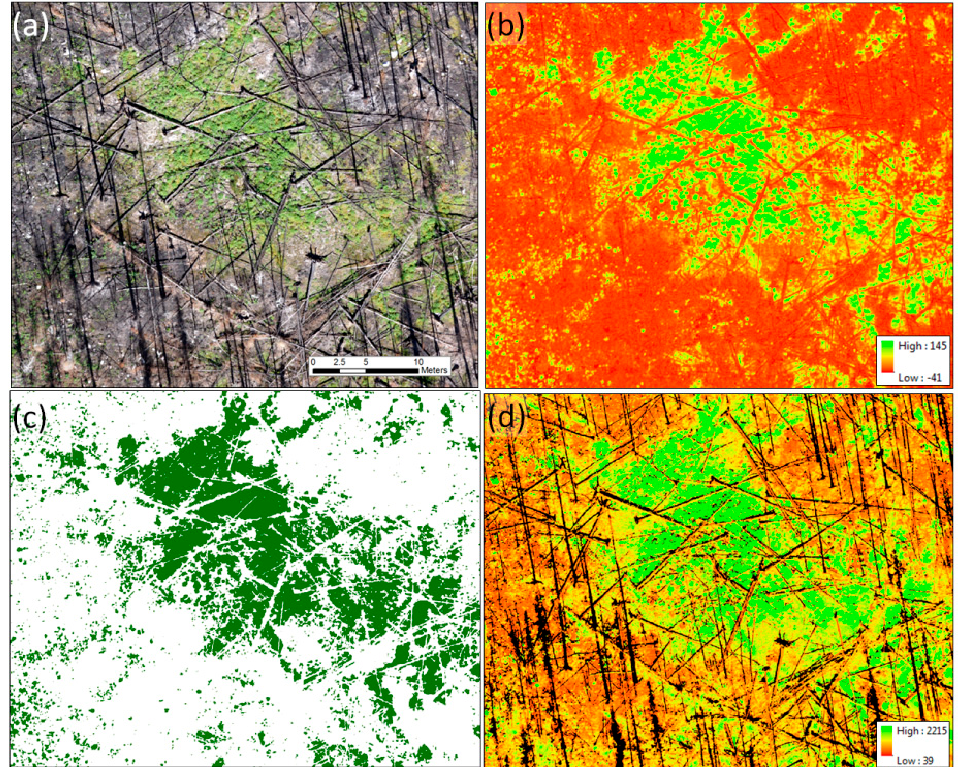
Figure 3. Portion of study area #1 showing ( a ) a 3 cm UAV photo-orthomosaic within study area #1 with burned and green vegetation; ( b ) the UAV Excess Greenness Index; ( c ) a binary classification of green vegetation derived from thresholding the Excess Greenness Index; and ( d ) the Char Index, where more highly charred areas with a low index value appear orange-red and masked tree shadows are shown in black.